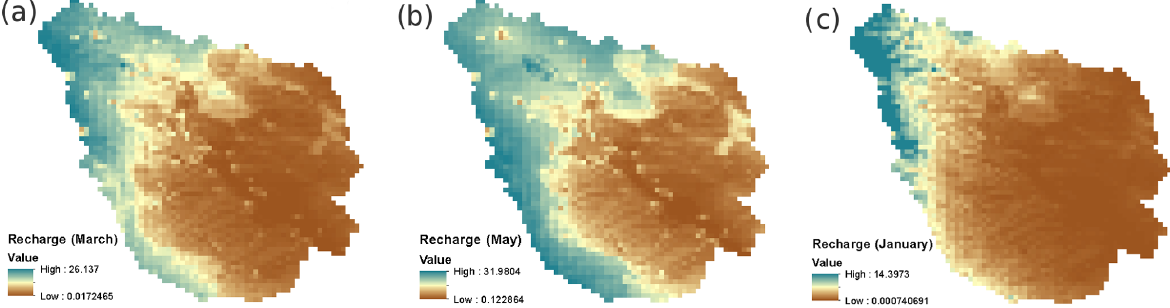
Figure 8. Spatial distributions of groundwater recharge in the Nägelstedt catchment (unit: mmmonth − 1 ) (a) in March, (b) in May, and (c) in January 2005.